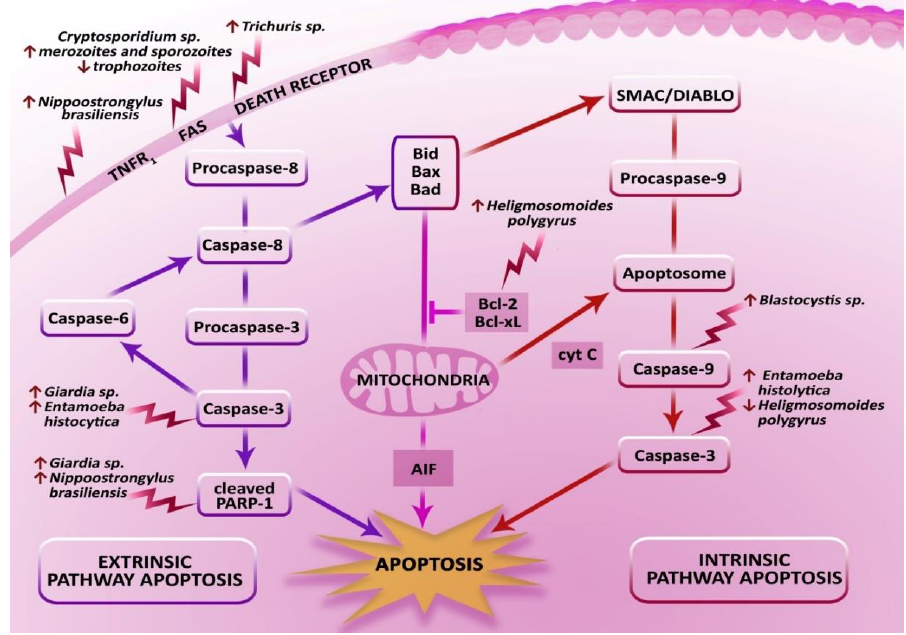
Figure 3. Induction of apoptotic signals in enterocytes by selected intestinal parasites.